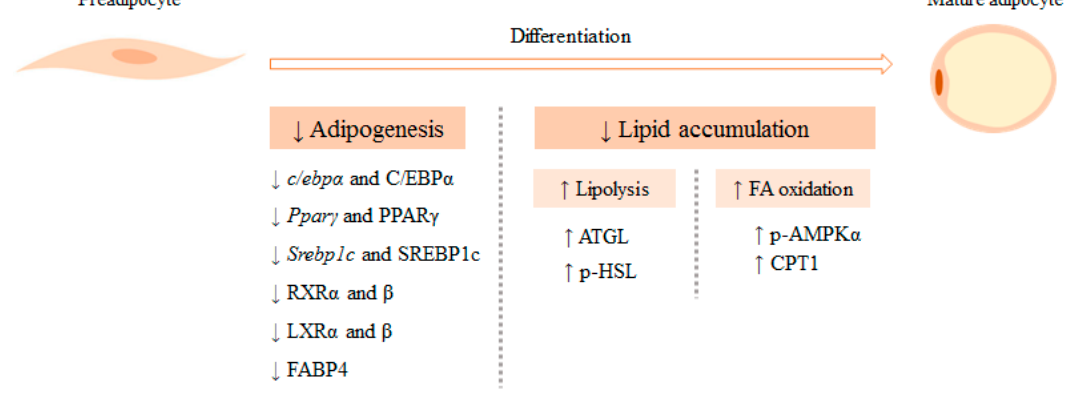
Figure 1. Anti-obesity mechanisms of action described in in vitro studies. ATGL: adipose triglyceride lipase, C/EBP α : CCAAT-enhancer-binding protein alpha, CPT1: carnitine palmitoyltransferase I, FABP4: fatty acid-binding protein 4, HSL: hormone sensitive lipase, LXR α : liver X receptor α , LXR β : liver X receptor β , p-AMPK α : phophorilated-AMP-activated protein kinase alpha, PPAR γ : peroxisome proliferator activated receptor γ , RXR α : retinoid X receptor α ; RXR β : retinoid X receptor β ; SREBP1c: sterol regulatory element-binding protein 1-c, ↓ : decreased, ↑ : increased.